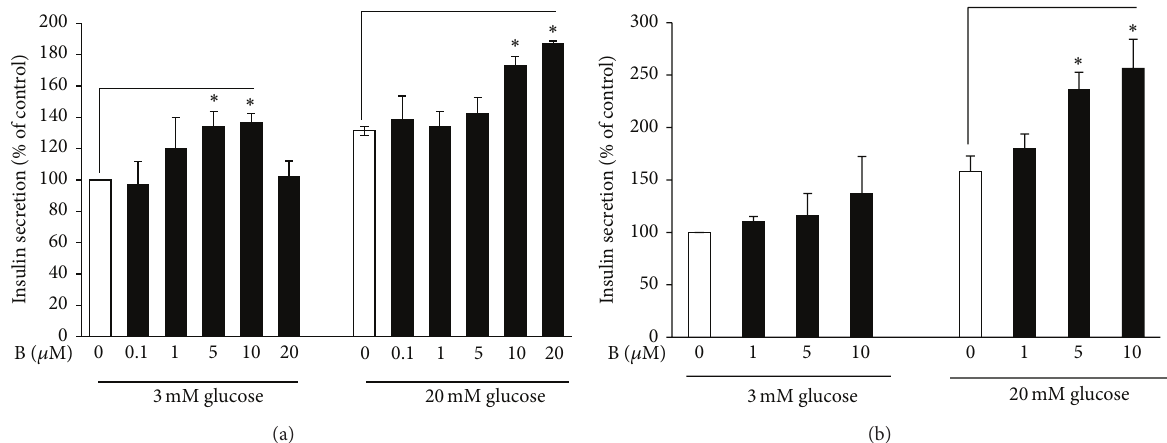
Figure 7: Baicalein enhanced glucose-stimulated insulin secretion from 𝛽 -cells and human pancreatic islets. INS382/13 cells (a) or islets (b) were incubated in KRB buffer with various concentrations of baicalein (B) in the presence of 3 mM or 20 mM glucose at 37 ∘ C for 30 min. Insulin secreted into supernatants was measured by ELISA. Data are expressed as means ± SEM from 6 experiments for INS382/13 cells and 3 experiments for human isles in duplicate each. ∗ 𝑃 < 0.05 versus